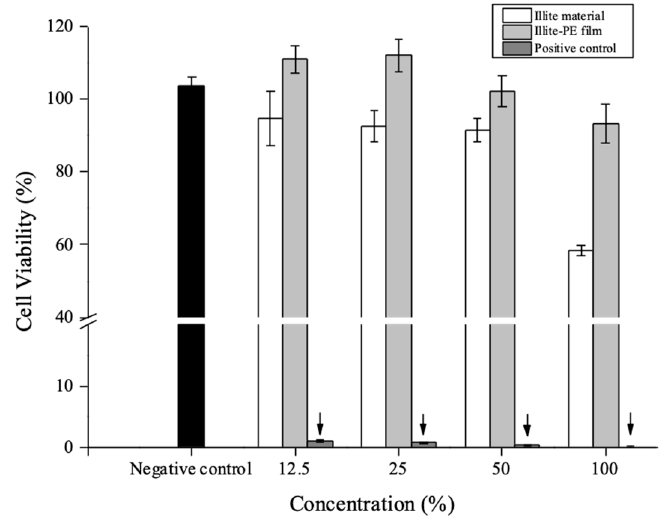
Figure 5. In vitro cytotoxicity of illite material and illite-PE film (negative control; high density. polyethylene film, positive control; 0.1 % ZDEC polyurethane film).